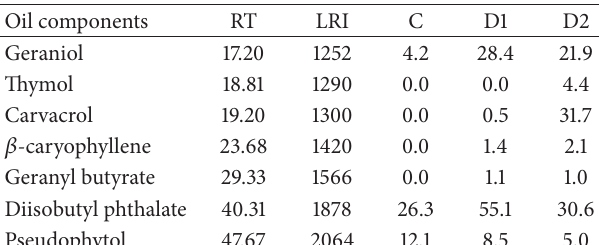
Table 1: Percentage of selected oil components of Thymus citri- odorus plant undergoing different PEG levels (0, C; 2%, D1; and 4%, D2). RT = retention time of compound; LRI = linear retention